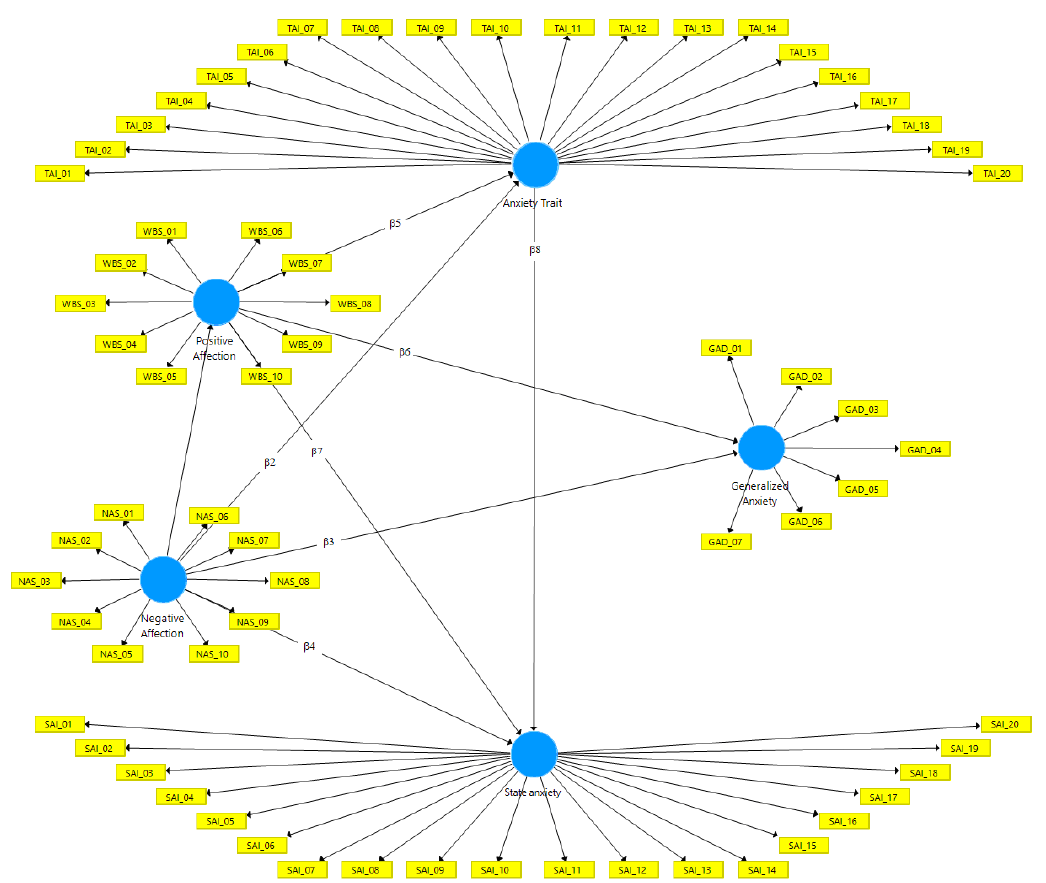
Figure 2. PANAS, GAD-7 and IDATE scale measurement model. Source: SmartPLS ® software, v. 3.3.2 [44]. Table 4. Diagram of paths for structural equations of the PANAS-GAD-7-IDATE model.